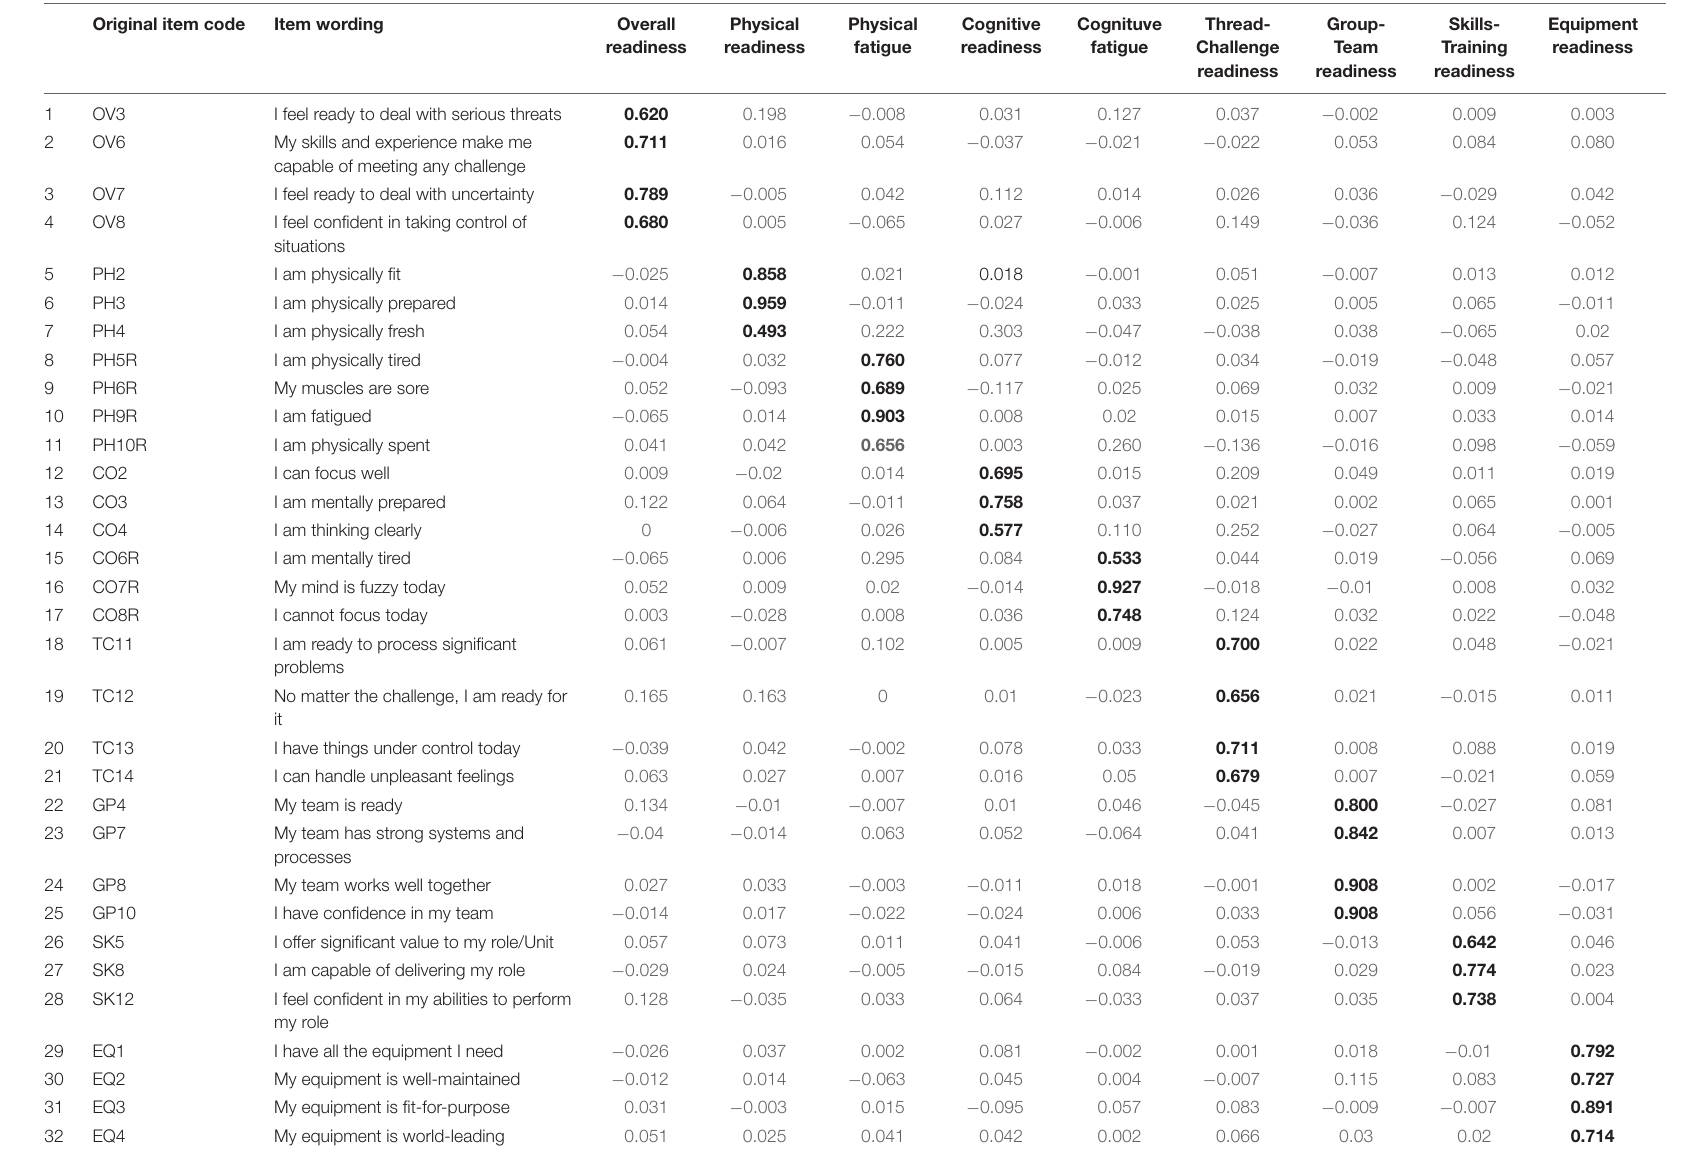
TABLE 3 | Factor loadings for the ARMSS from study